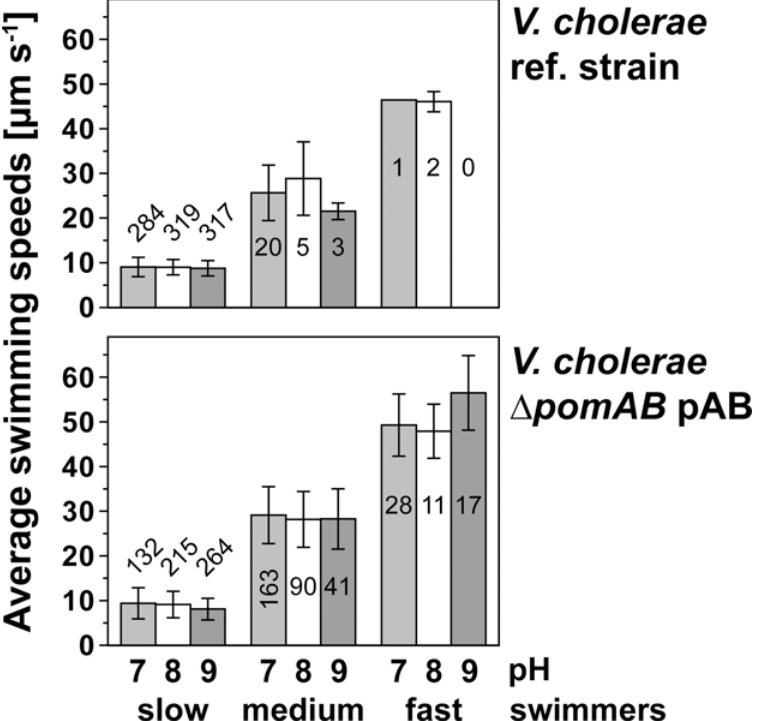
Fig 5. Distribution of swimming speeds of the V . cholerae reference strain and of V . cholerae Δ pomAB expressing pomA and pomB in trans. Tracks were recorded in LB-Na + adjusted with Tris to pH 7.0 (light grey bars), pH 8.0 (white bars), or pH 9.0 (dark grey bars). Tracking results of individual cells were assigned to three main classes of velocities ( “ slow ” , “ medium ” and “ fast ” ). The numbers in the bars indicate the number of tracks used to calculate the mean values and standard deviations. Minimum, median and maximum values are given in the supporting information (S1 Table).